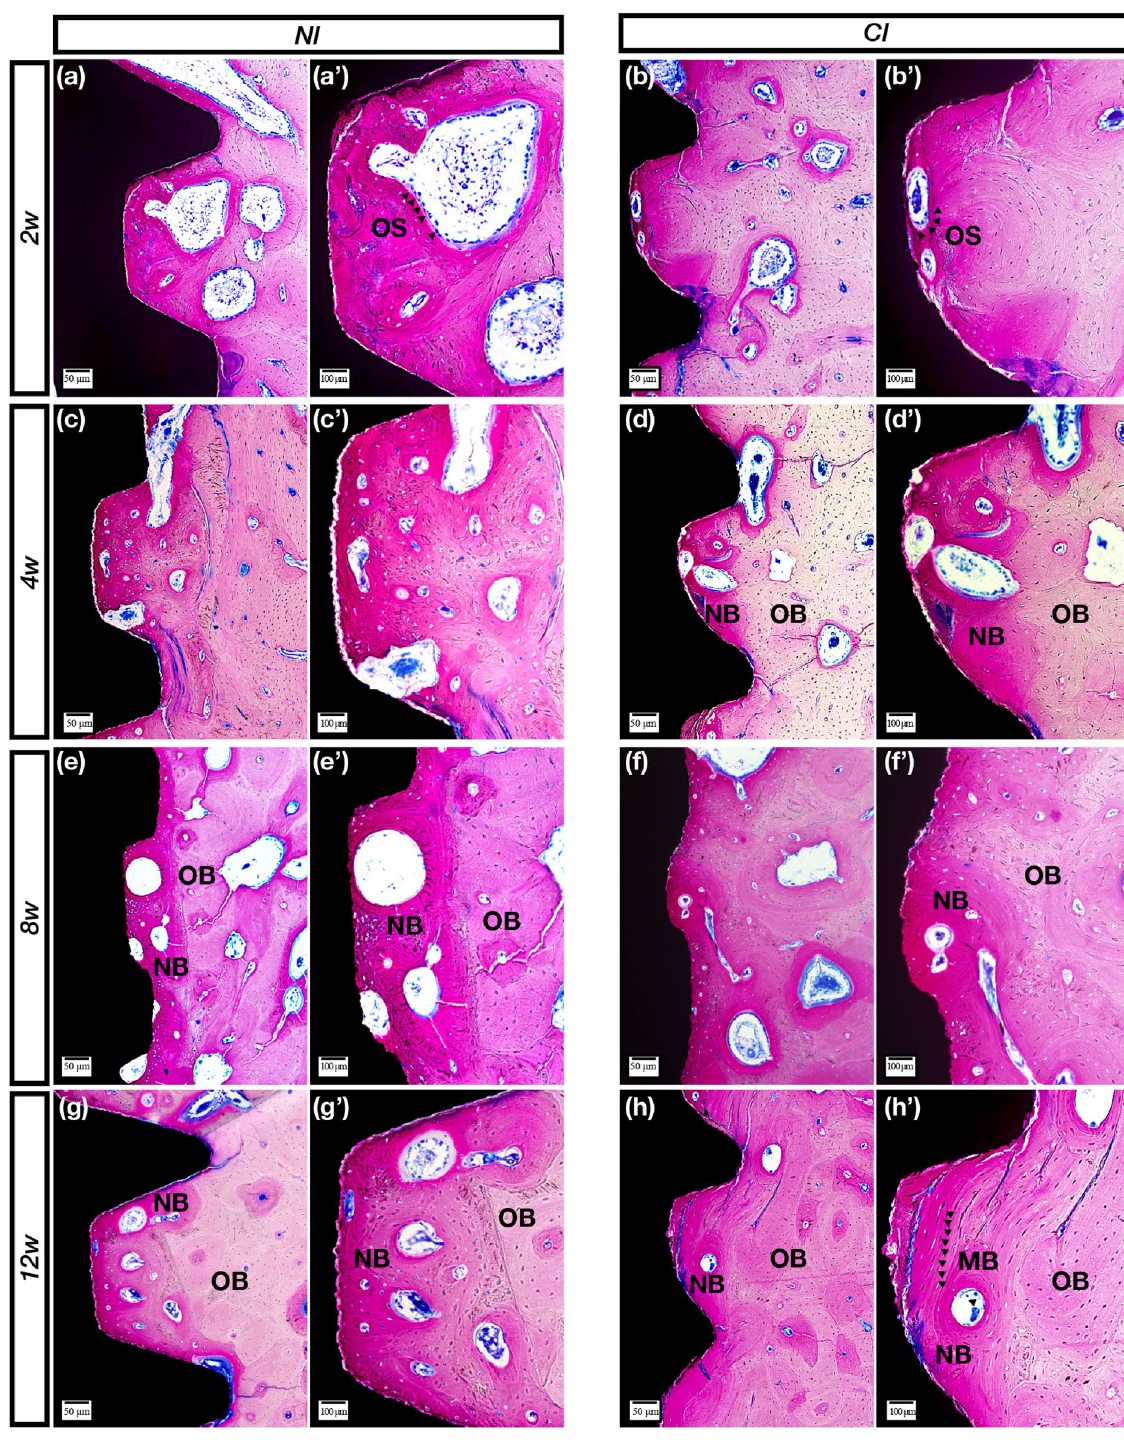
Figure 2. Methylene blue staining. ( a , a ′ ) Bone resorption lacuna of the NIs formed by some osteoclasts (black arrows) inside the thread in the 2nd week. ( b , b ′ ) Bone resorption lacuna of the CIs formed on the surface by some osteoclasts (black arrows) inside the thread in the 2nd week. ( c , c ′ ) On the 4th week, some bone resorption lacunae were formed on the surface of the NIs. ( d , d ′ ) In the 4th week, the bone resorption area of the control group increased, and deep pink new bone (NB) was observed. ( e , e ′ ) In the 8th week, almost no osteoclasts were observed, and extensive NB was observed between the threads. ( f , f ′ ) Almost no osteoclasts were observed in the experimental group, and the boundary between new and old bone became blurred. ( g , g ′ ) The boundary between new and old bone became more blurred for the NIs. ( h , h ′ ) Mineralized bone was observed on the surface of the CIs, and the NB became more mature in the 12th week. OS (osteoclasts); NB (new bone); OB (old bone); (MB) mineralized bone. Scale bars represent 50 μm ( a – h ) and 100 μm ( a ′ – h ′ ); original magnification: ( a – h ) × 10, ( a ′ – h ′ ) ×